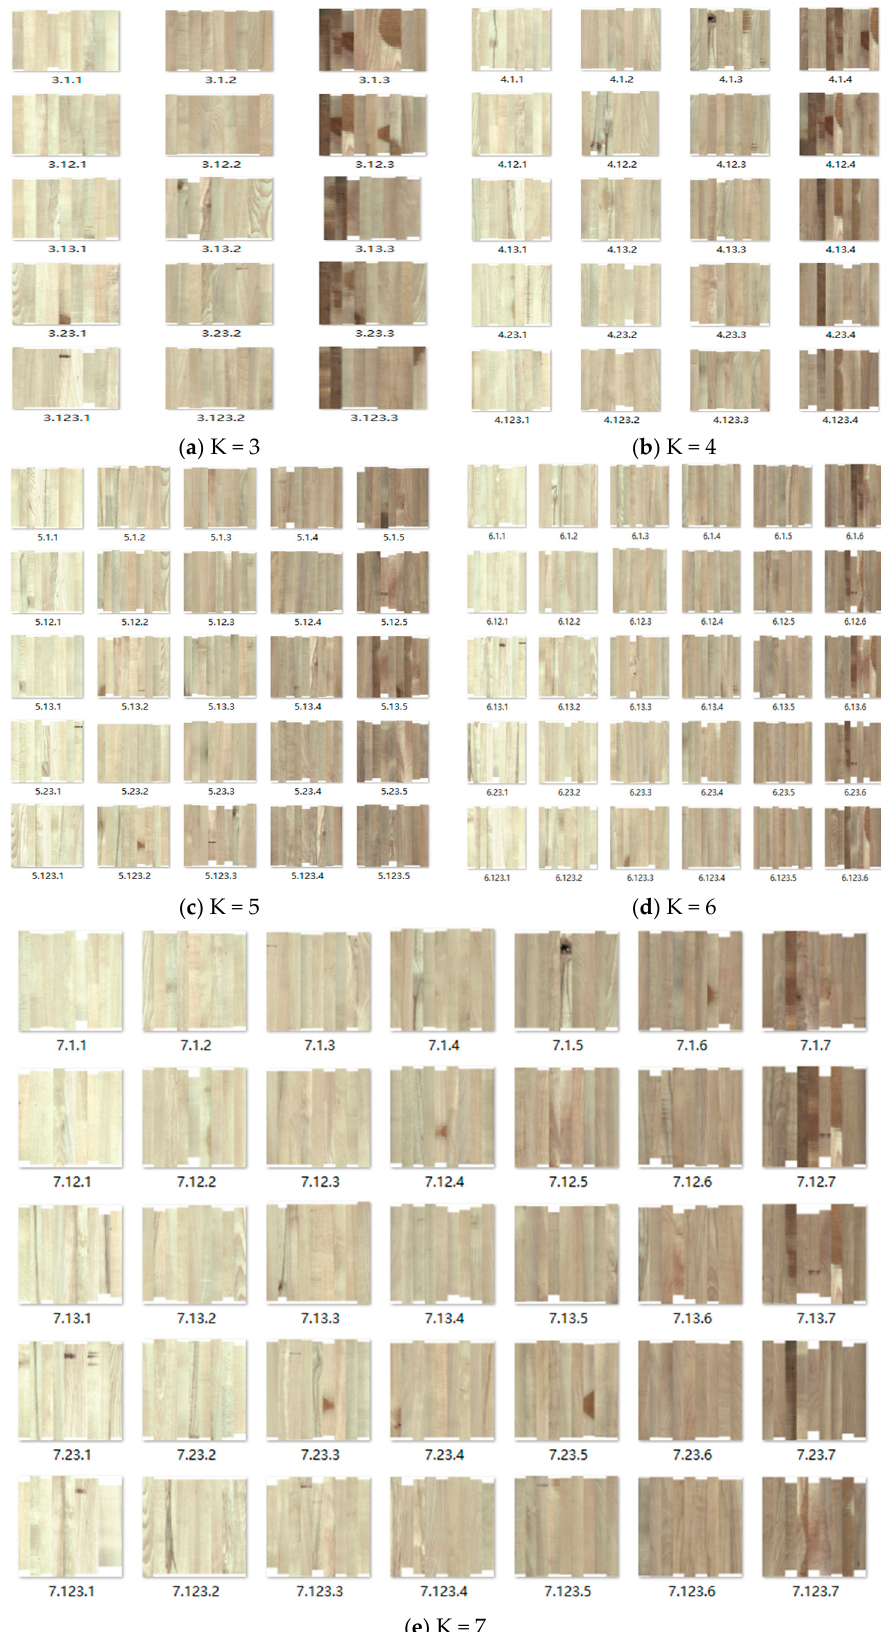
Figure 6. K = 3–7 clustering result images.